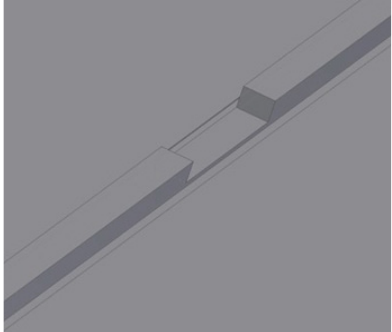
Figure 14. Inventor Professional 2012 design of a gasket (140 µm wide and 25 µm deep) aligned to the channel and sieve.